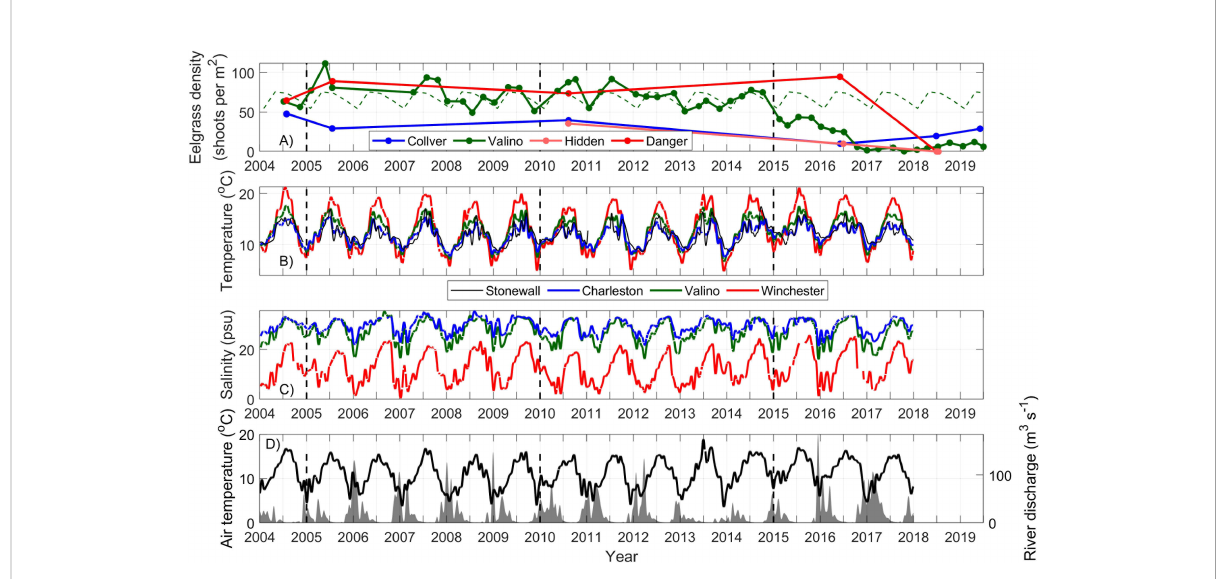
FIGURE 3 (A) Eelgrass density at 4 stations in South Slough. The 2004-2014 climatology for Valino is shown in broken green line. (B) Long-term hydrographic characteristics at 4 SSNERR stations, Charleston WQ (blue), Valino WQ (thick green), Winchester WQ (red) and the Stonewall buoy (black), showing low-pass fi ltered water temperature over 2014 – 2018. (C) same as in (B) but for salinity. (D) Air temperature at the North Bend Airport meteorological station (black) and South Fork of the Coos River discharge (gray). For locations, see Figure